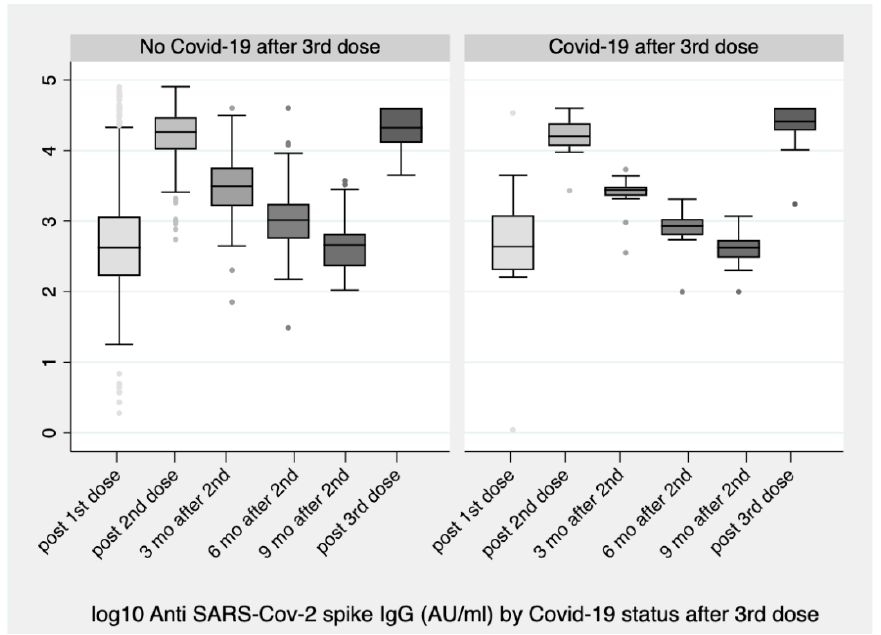
Figure 3. Boxplots of antibody levels (logarithmic scale) of subjects infected 2 – 3 months after the booster dose versus those not infected. No significant differences were observed.